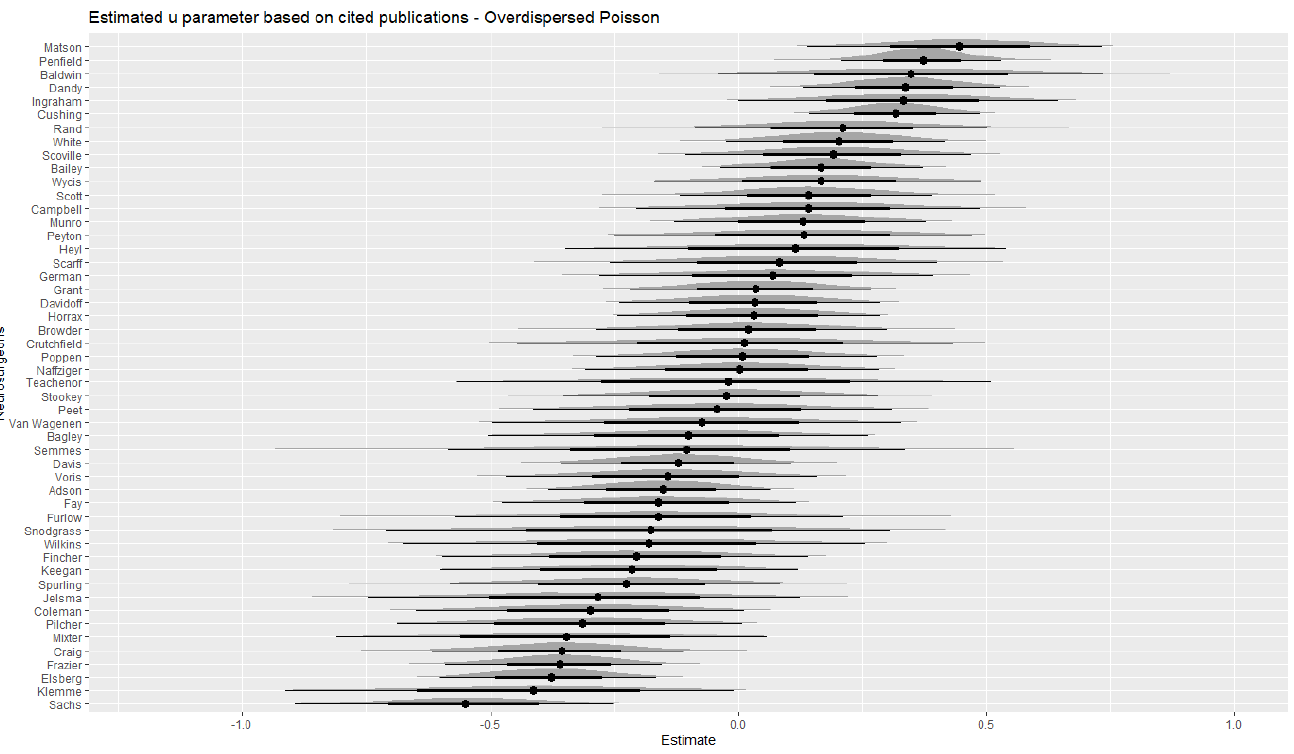
Figure 3. Estimated individual deviations from the overall hit rate obtained from the overdispersed Poisson model for cited papers.